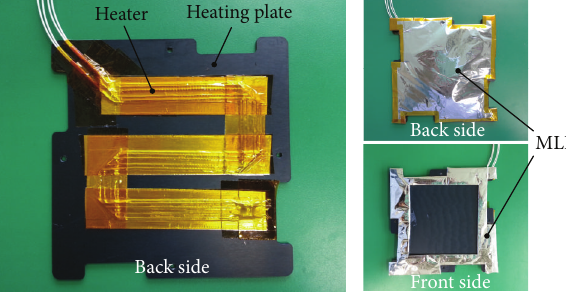
Figure 15: Configuration of indirect heating plate.